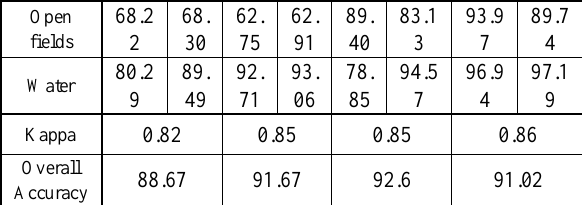
Table 3. Accuracy assessment from 2004 to 2013.